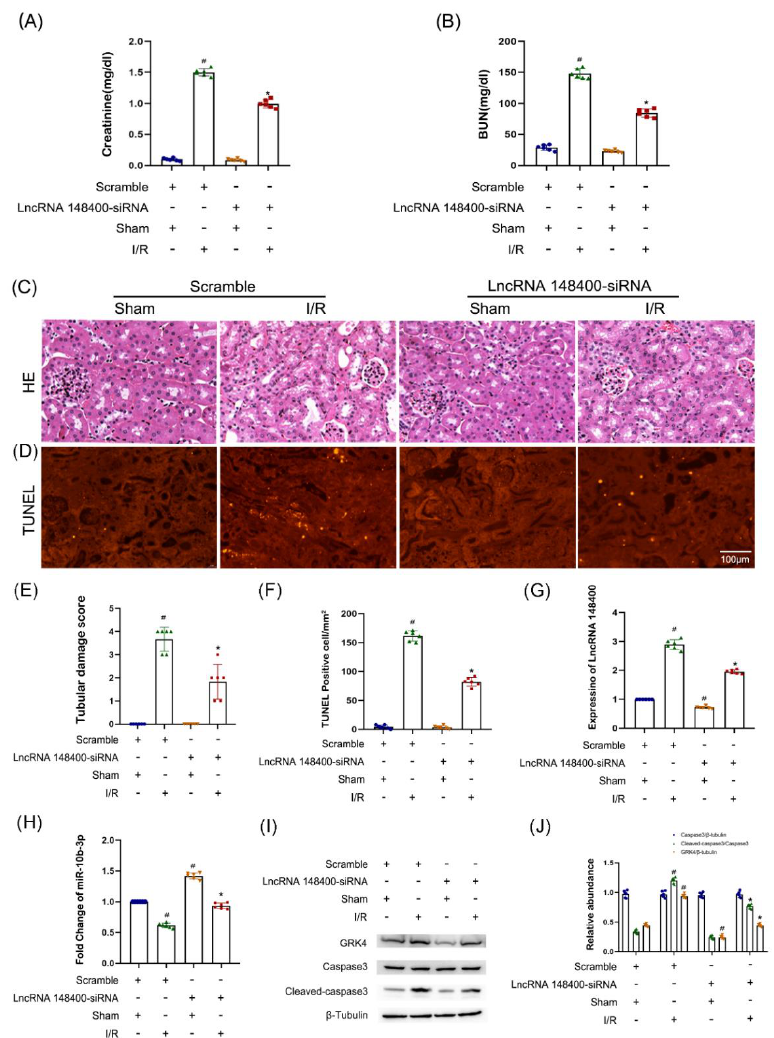
Figure 8. LncRNA148400 siRNA ameliorates I/R − induced mice AKI. The C57BL/6J mice were injected with lncRNA148400 siRNA via tail vein for 12 h, and then the bilateral renal pedicles were